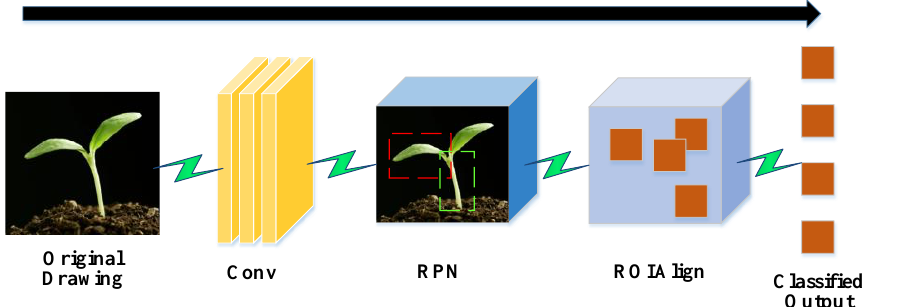
Figure 2. Frame structure diagram of MRCNN algorithm adopted to feature extraction of seedling Figure 2. images.